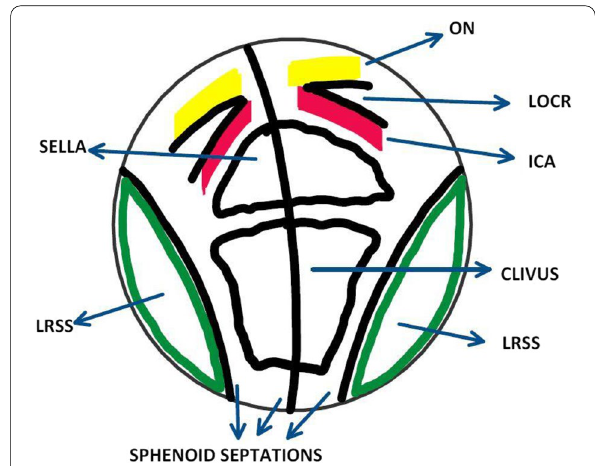
Fig. 2 Line diagram showing the endoscopic anatomy in the sphenoid sinus. ON, optic nerve; LOCR, lateral opticocarotid recess; ICA, internal carotid artery; LRSS, lateral recess of sphenoid sinus